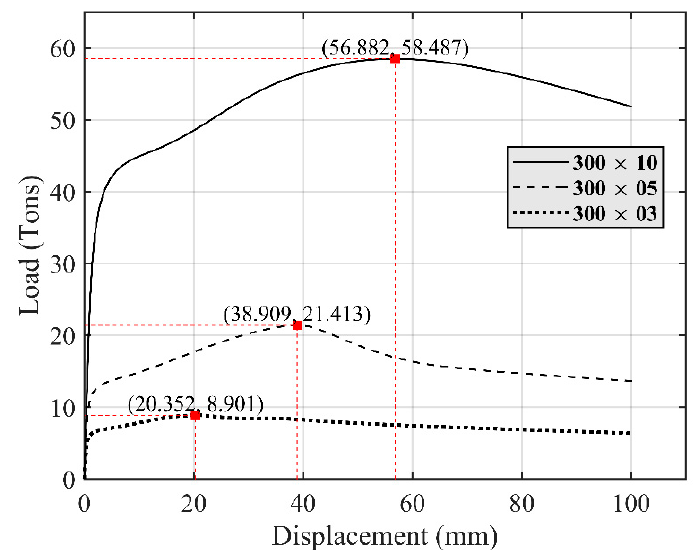
Figure 7. Load and displacement responses of unstiffened columns.